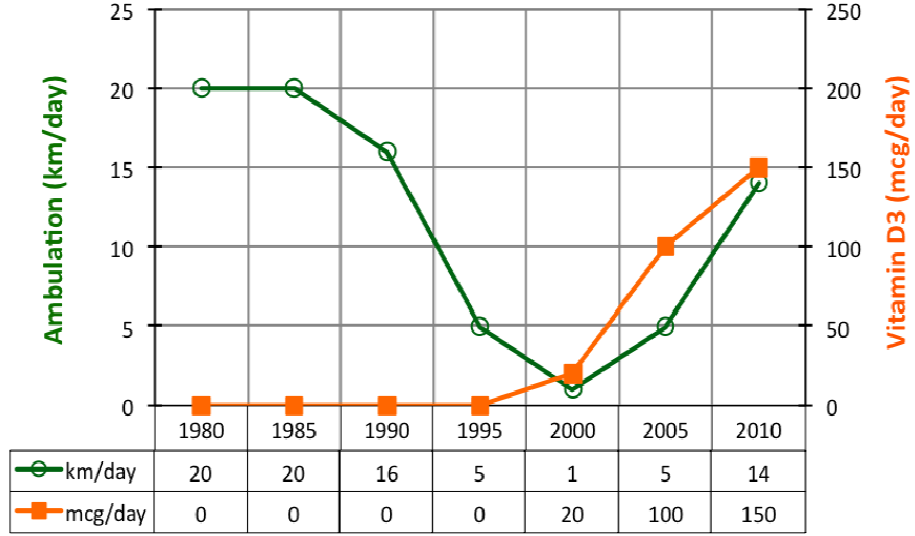
Figure 2. Ambulation, walking distance expressed in km/day and vitamin D3 supplementation